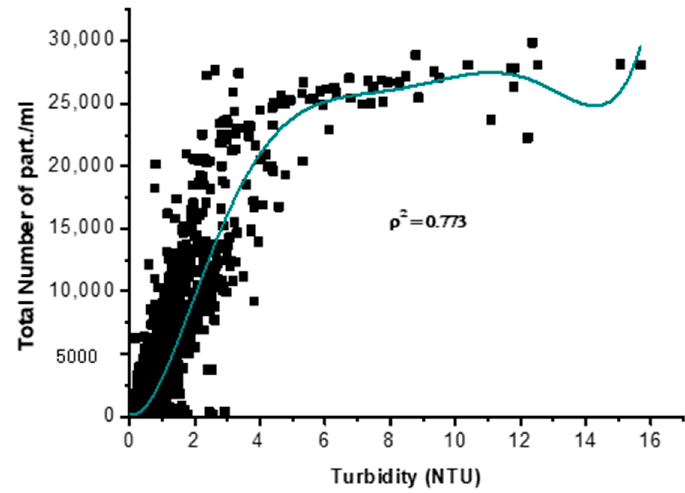
Figure 3. Graph of the total number of particles/mL with respect to turbidity.